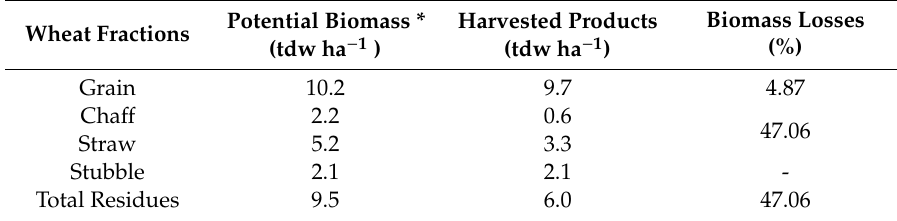
Table 7. Wheat grain and residues losses